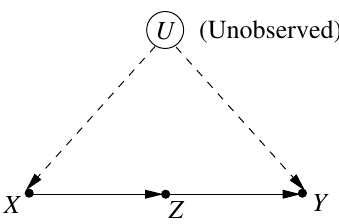
Figure 3: A model in which variable Z acts as a mediating instrument for identifying the causal effect of X on Y in the presence of unknown or unobserved confounders ( U